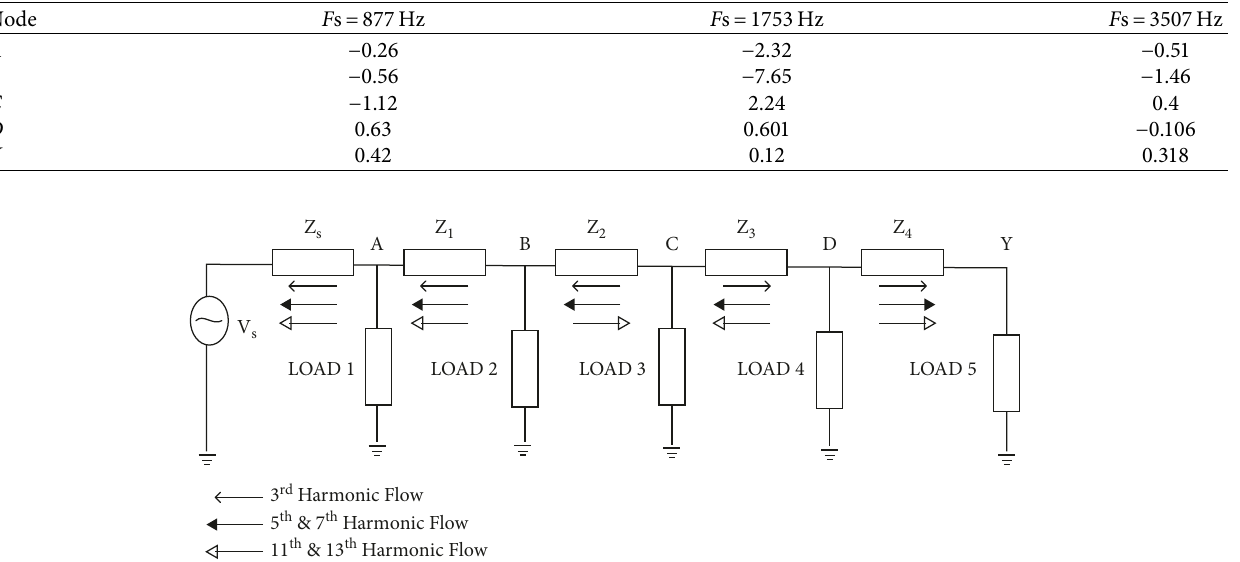
Figure 9: Harmonic power flow representation with 6-pulse and 12-pulse converter (at Node D and Node B , respectively) along with one 3rd harmonic source at C . Table 9: Outcomes of 6-pulse and 12-pulse converter connected at node B and node D , respectively, with DWT.